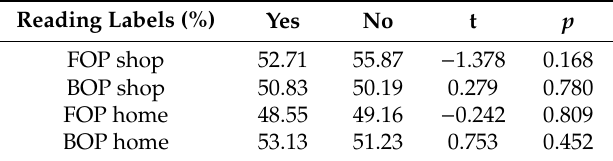
Table 10. Reading food labels by being on a special diet for health